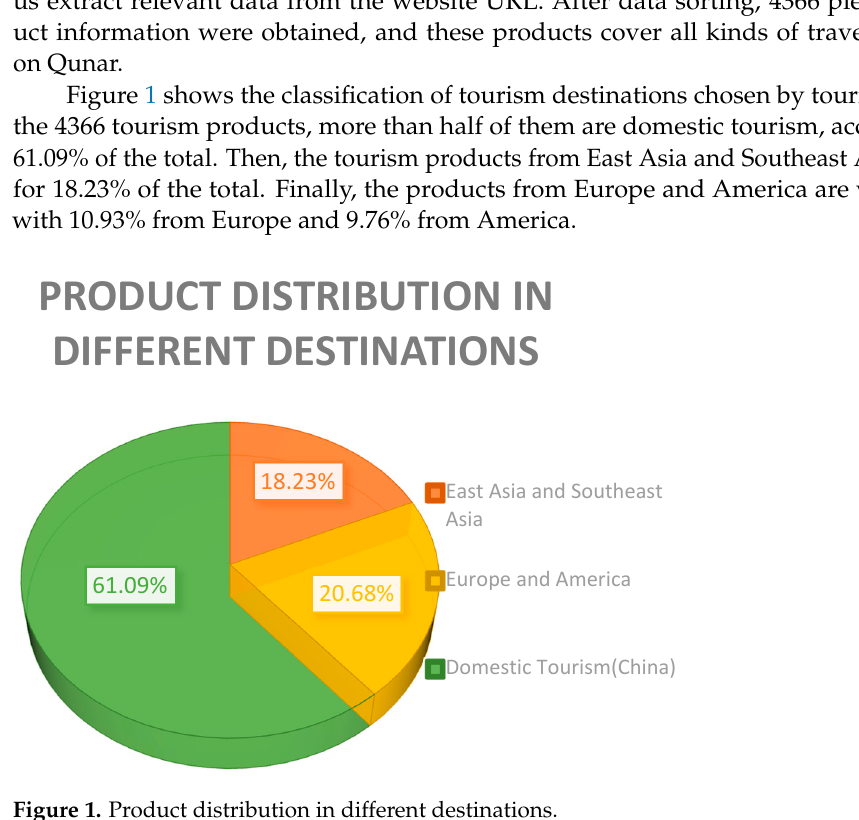
Figure 1. Product distribution in different destinations.